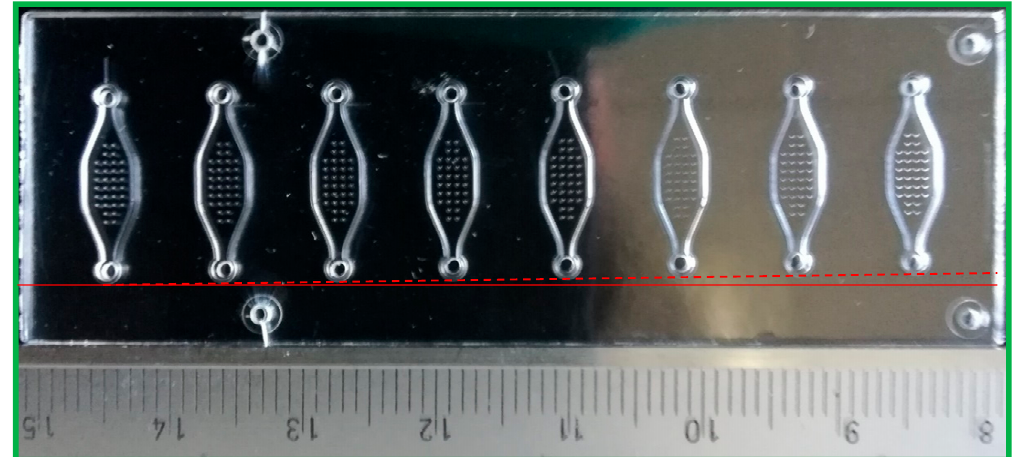
Figure 6. A polymer chip fabricated using a shim without alignment marks.